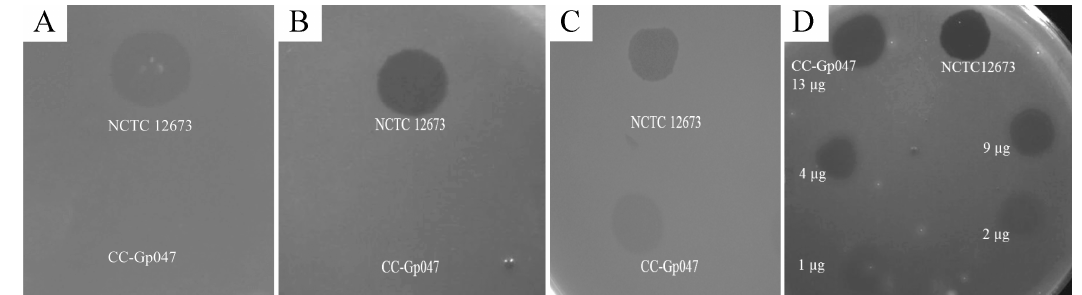
Figure 2. CC-Gp047 did not clear growth of the aflagellate mutant 11168 ∆ pseG ( A ); Growth clearance was also not observed when CC-Gp047 was spotted onto the acetamidino-mutant 11168 ∆ pseA ( B ); Growth clearance was restored when 11168 ∆ pseA was complemented with a wild type copy of the pseA gene ( C ); ( D ) CC-Gp047 showed a dose dependent growth clearance when different concentrations (13, 9, 4, 2 and 1 µ g) were spotted onto a growing C. jejuni